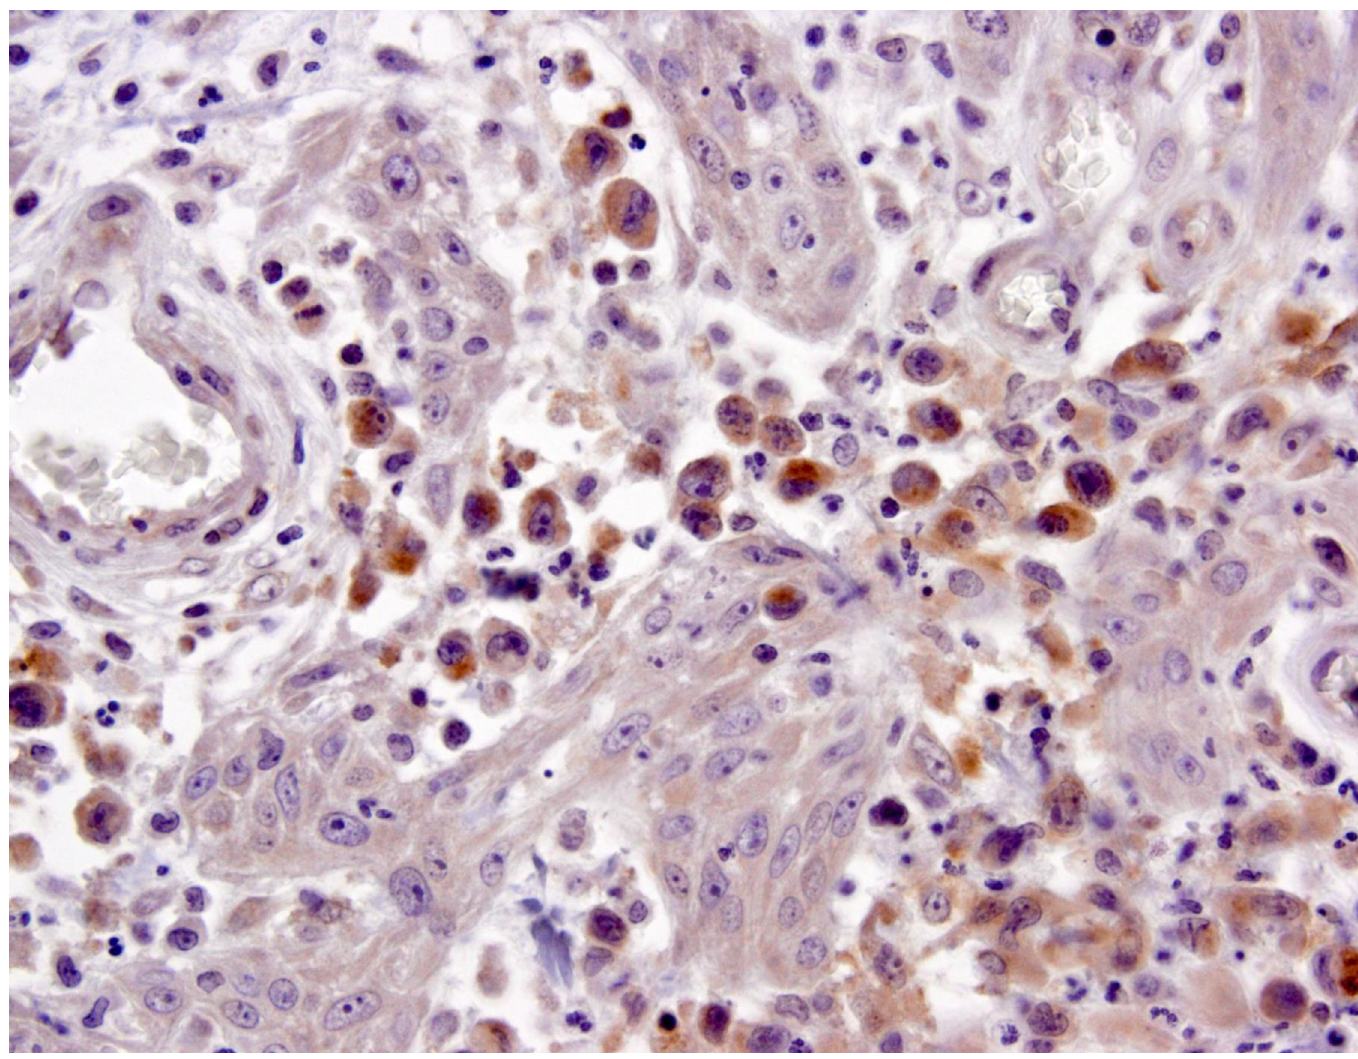
Fig 1. Large atypical cells of LyP-A express IL-13. Keratinocytes and granulocytes are unstained. Immunohistochemistry was done on formalin-fixed paraffin-embedded tissue with a mouse anti-human IL-13 monoclonal antibody (1microgram/ml) from Abcam (Cambridge, UK).